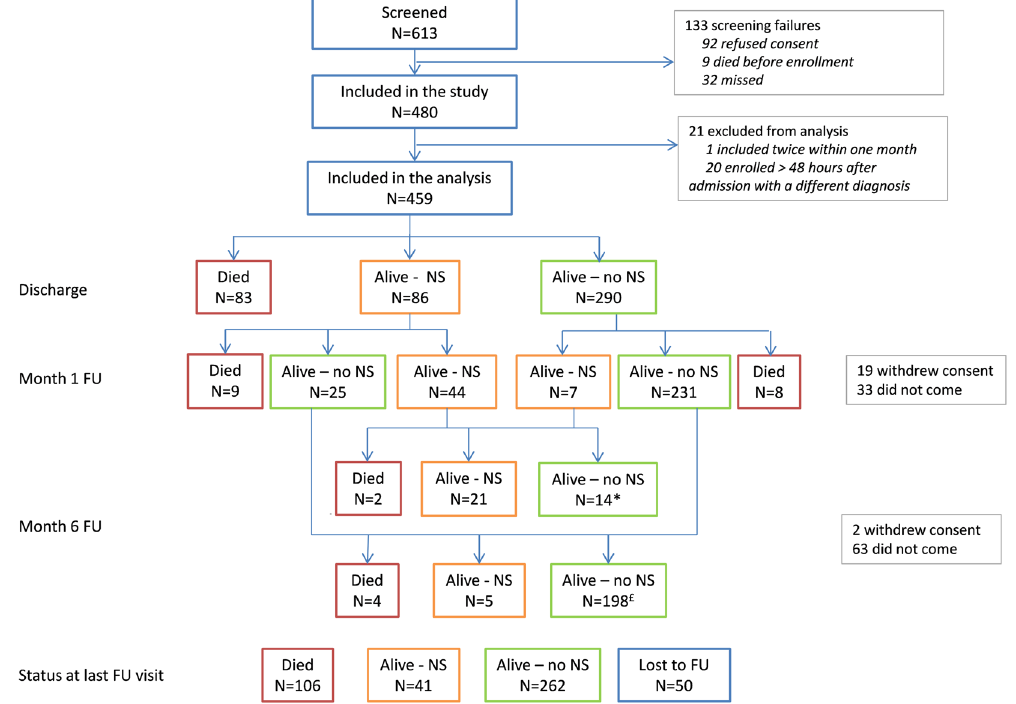
Figure 1. Study flow-chart. NS: Neurological sequelae; FU: follow-up; Lost to FU: withdrew consent or did not come to any FU visit * including 1 with neurological sequelae at discharge and missing visit at month 1 £ including 1 with no neurological sequelae at discharge and missing visit at month